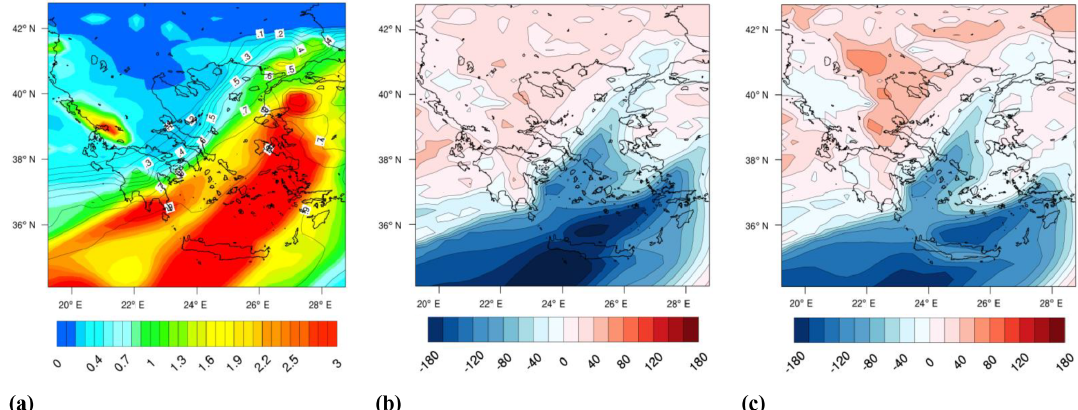
Figure 11. The spatial distribution of the (a) total AOD (at 550nm). Isolines indicate the dust fraction of the total AOD model values. The map corresponds to 12:00UTC, when maximum AOD ≈ 5 . 2. (b) Dust plume effect on GHI and (c) DNI (in Wm − 2 ) at the surface, averaged for the daytime hours of the extreme dust event of 1 February 2015 over Greece as predicted by COSMO-ART.